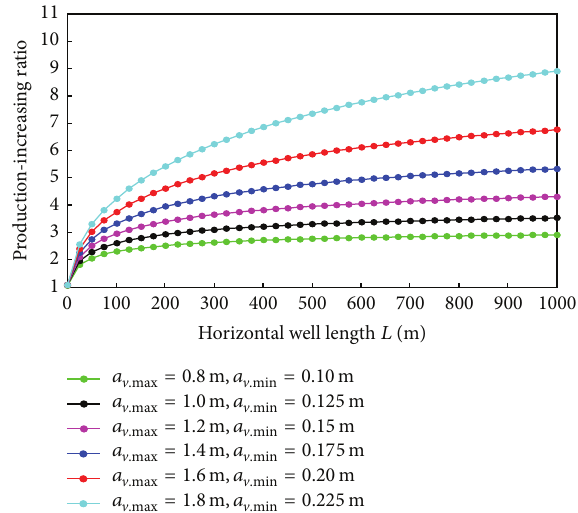
Figure 13: Effect of distance of acid-rock reaction ( 𝑎 V . max , 𝑎 V . min ) on production-increasing ratio ( 𝐿 = 1000 m, 𝑟 𝑤 = 0.1 m, 𝜀 = = 0.56 , 𝜇 = 0.023 mPa ⋅ s, 𝑍 = 0.9 , 𝑇 = 366 K, 0.00016 m, 𝛾 𝑔 𝑔 = 20 MPa, 𝐾 = 0.6 mD, 𝐾 = 0.1 mD, 𝐾 = 1.2 mD, ℎ = 10 m, 𝑝 𝑤𝑓 ℎ V 𝑎ℎ = 0.1 mD, 𝑑 = 1.6 m, and 𝑑 = 0.2 𝐾 𝑑ℎ V . max V . min